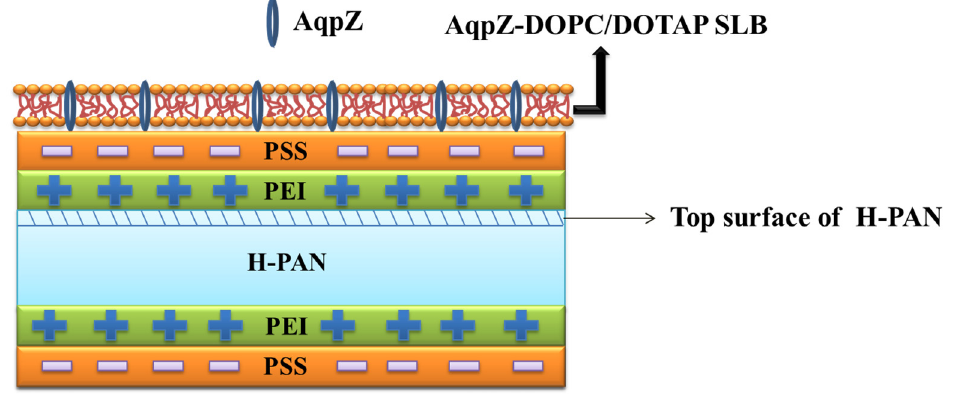
Figure 1. Schematic diagram of the formation procedures for AqpZ-incorporated double-skinned FO